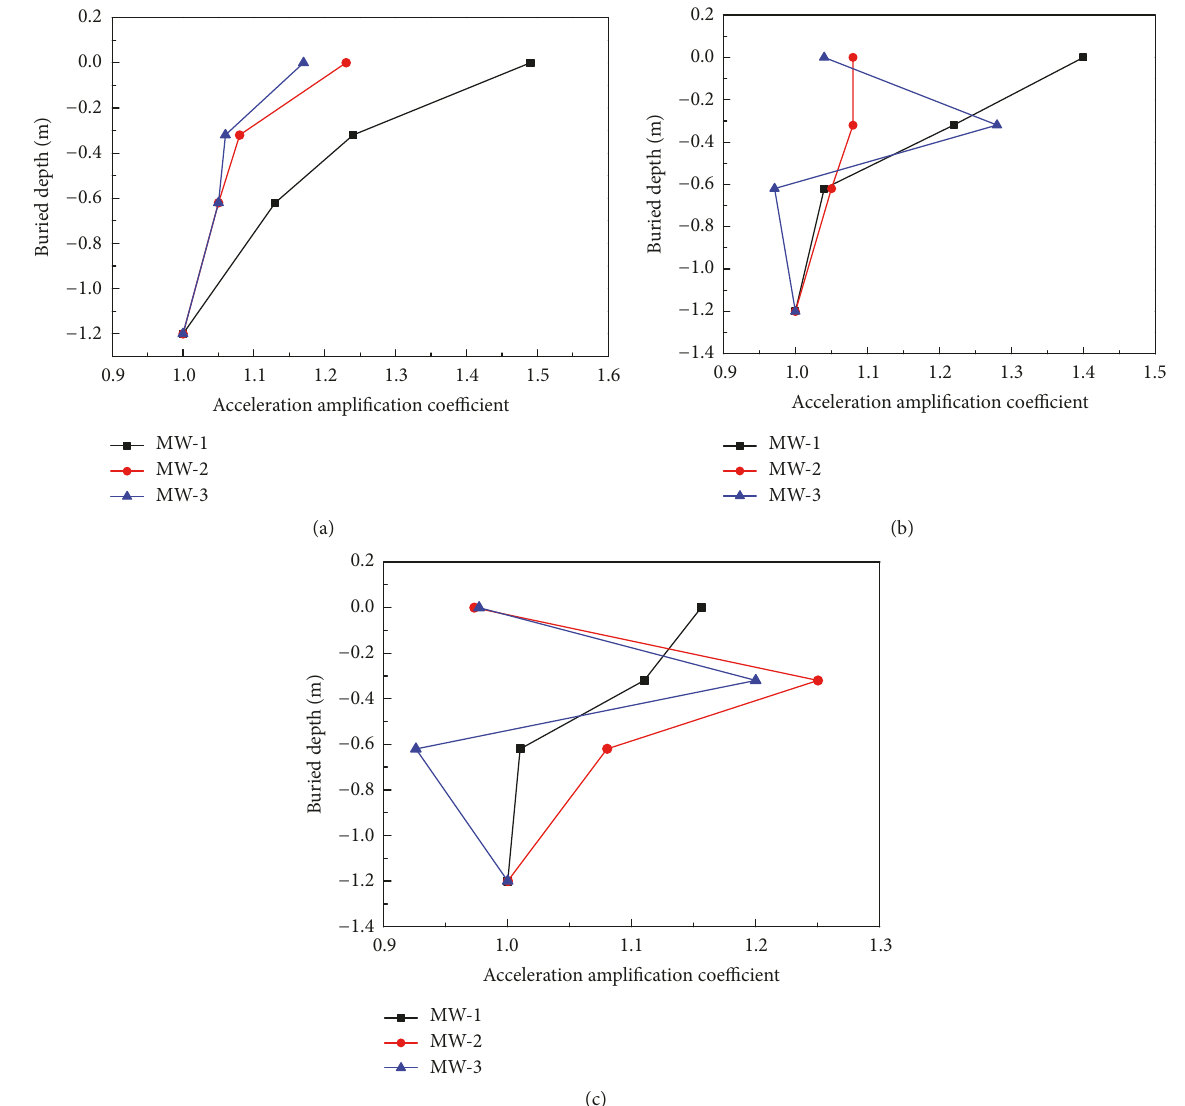
Figure 8: Soil acceleration amplification coefficients of (a) test 1, (b) test 2, and (c) test